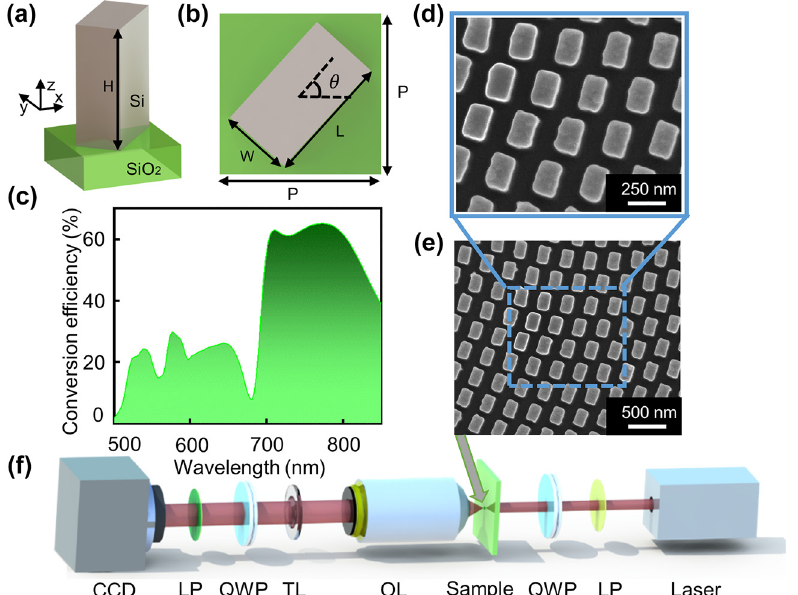
Figure 3: Nanopillar design and experimental setup. (a)ThebuildingblockofthemetasurfaceconsistsofamorphousSinano-finsittingonasilicasubstrate.(b)Topviewofthebuildingblockwith nano-fin length L = 240 nm, width W = 135 nm, and height H = 365 nm. The nano- fi n can rotate in the x – y plane with an angle θ to realize the required phase according to the Pancharatnam – Berry phase with a pitch P = 300 nm. (c) The simulated polarization conversion ef fi ciency (de fi ned as the ratio between the total optical power of the cross-polarized light to the input optical power) of the unit cell. The expanded (d) and top-view (e) scanning electron microscopy (SEM) images of a portion of the fabricated sample. (f) Experimental setup for the optical characterization (quarter-wave plate (QWP), linear polarizer (LP), objective lens (OL), tube lens (TL), and charge-coupled device